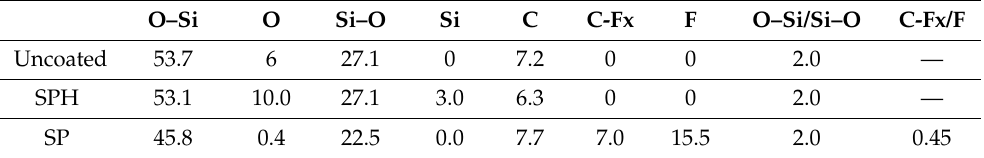
Figure 11. ( a ) Highly reflective, anti-soiling nanoparticle texture solar mirrors (7.6 × 7.6 cm 2 ) with no coating, super-hydrophilic (SPH) coating, and super-hydrophobic (SP) coating. Insets are water contact angle measurements on the coated mirrors (the measured water droplet volume = 5–10 µ L). ( b ) SEM images of coated mirror surface, showing characteristics of SPH nanotexturing. ( c ) SEM cross-sectional view of SPH coating [62]. Table 1. Chemical composition of SP and SPH coating determined by XPS